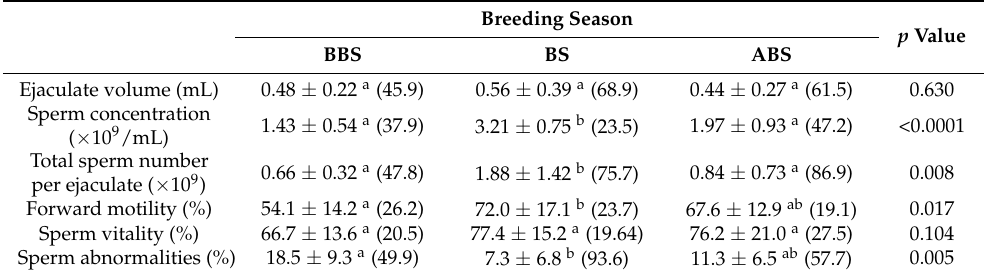
Table 1. The measures (mean ± SD (CV%)) of routine semen evaluation tests in the selected periods of routine ram examination in the herd, before the breeding season (BBS), during the breeding season (BS), and after the breeding season (ABS).